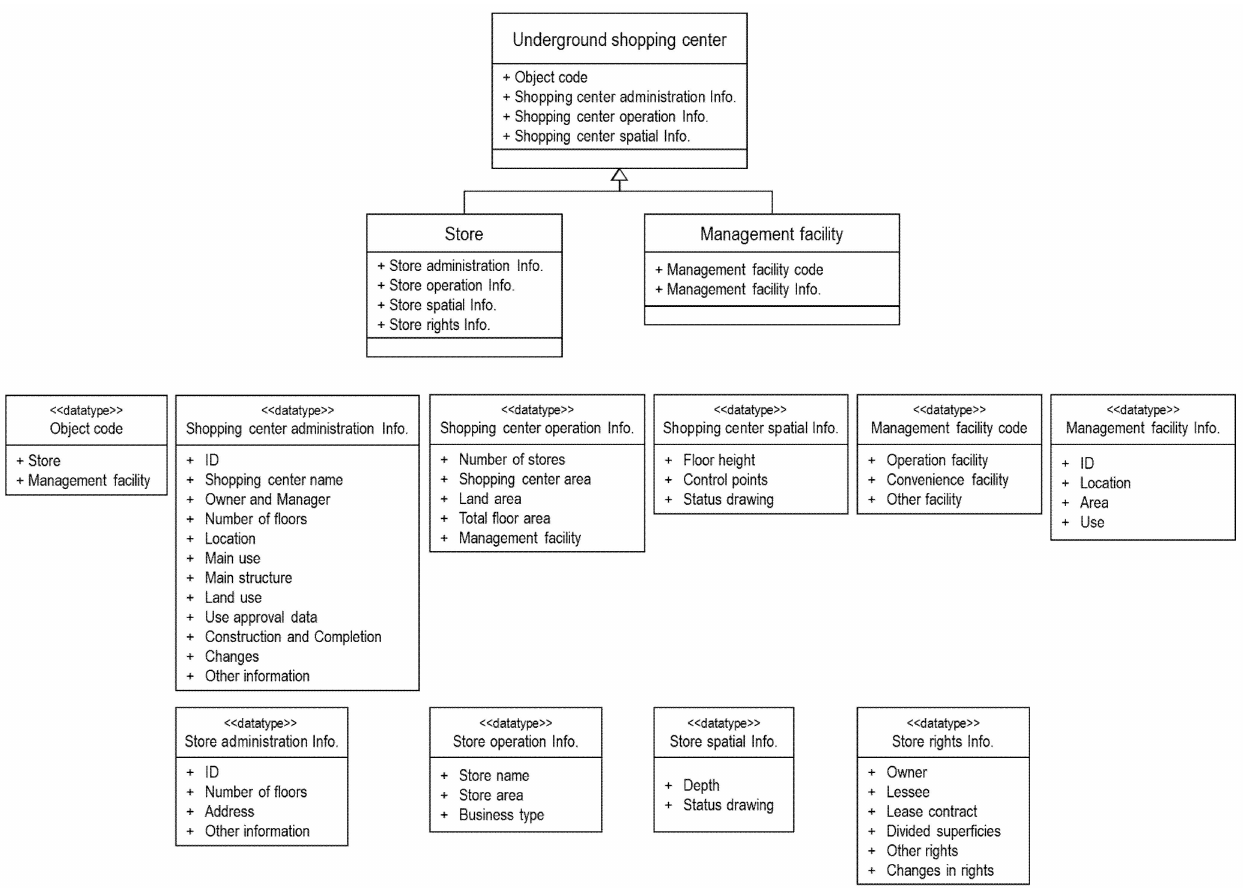
Figure 11. Data model for underground space registration